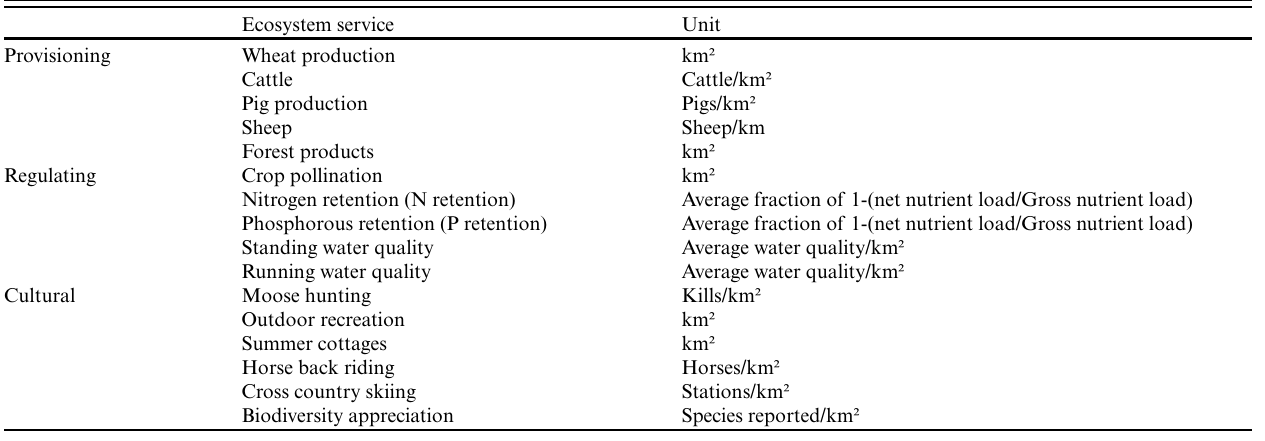
Table 2 . Ecosystem services by category and the units in which they were measured.